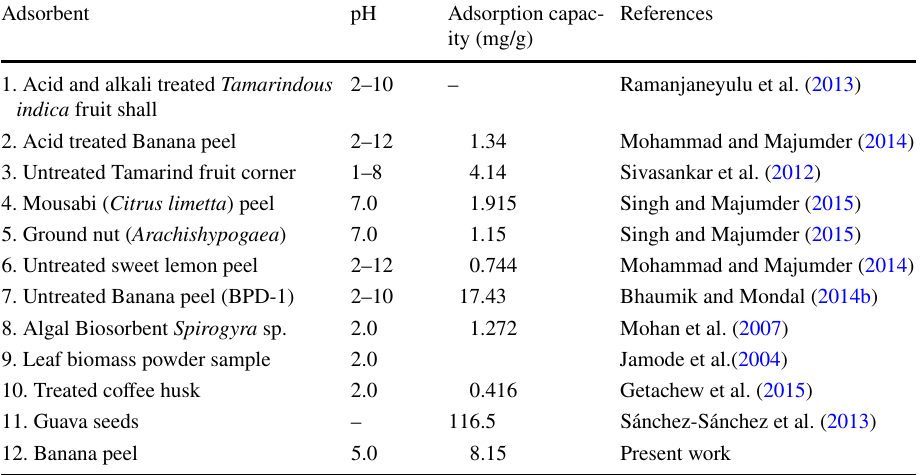
Table 7 Comparative evaluation of adsorption capacities of various biosorbents for fluoride removal